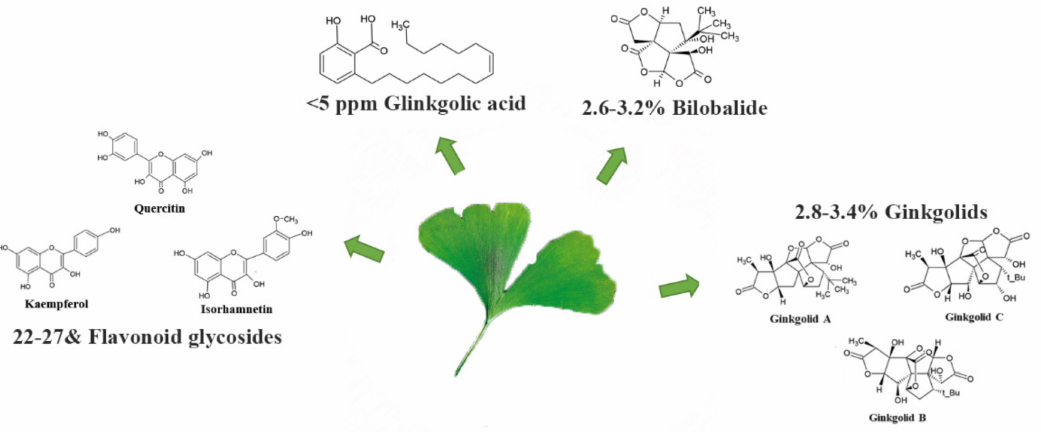
Figure 3. EGb 761 ® active